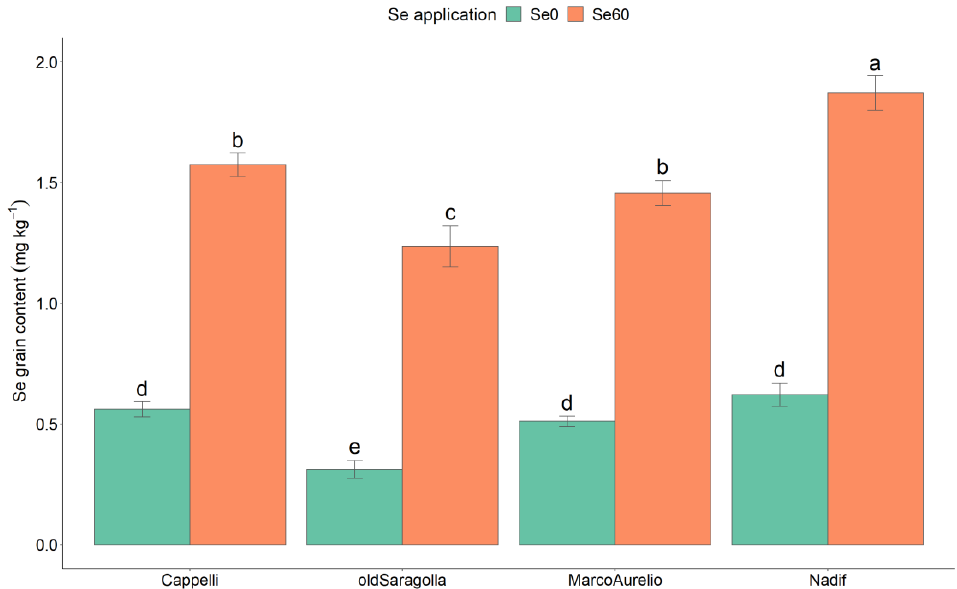
Figure 4. Effect of interaction variety × selenium application on Se content in grain. Se0, no selenium application; Se60, selenium application. Tukey HSD significant differences ( p < 0.05) are indicated by different letters. Vertical bars indicate standard errors (n = 24).